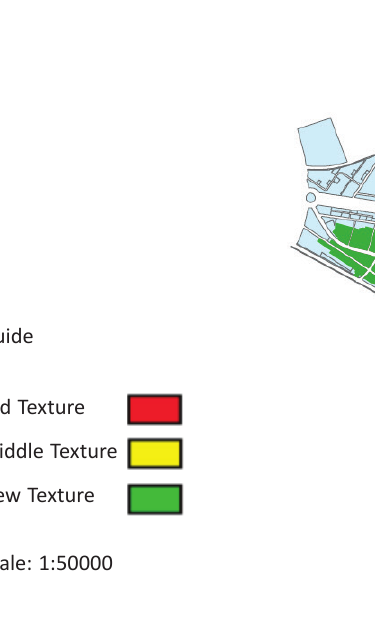
Figure 3. Division of districts in Bojnourd city (source: Ziari et al., 2012, p. 227)